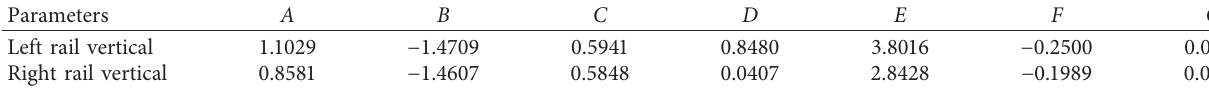
Table 2: Parameters of the vertical track irregularities [24].